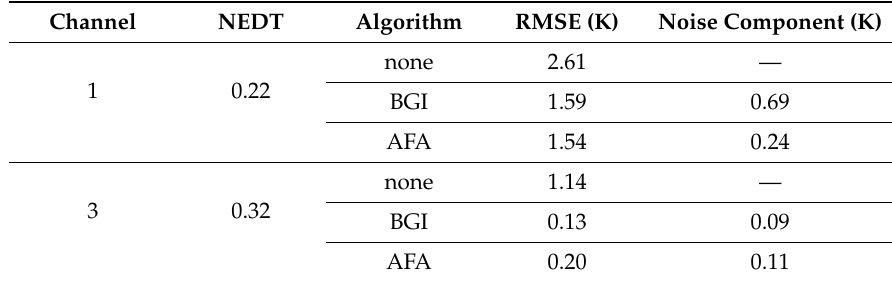
Figure 7. Bias and standard error for ATMS observations before and after the remapping process for ATMS ( a ) channel 1 and ( b ) channel 3. Black curves and error bars represent the original observations. Red and blue curves and error bars represent the remapped observations by the BGI and the AFA, respectively. Table 2. Root-mean-square errors (RMSEs) and noise components for the raw and remapped observations relative to the simulated